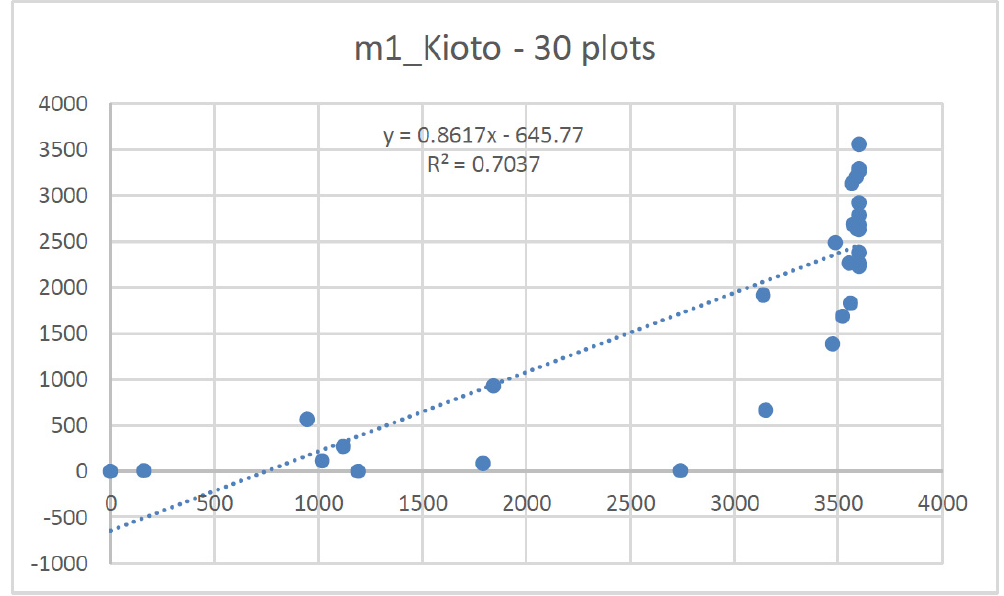
Figure A4. Reference area compared to estimated forest area by Method 1 for test plots (30 × 30 m 2 ) as defined by the UNFCCC.